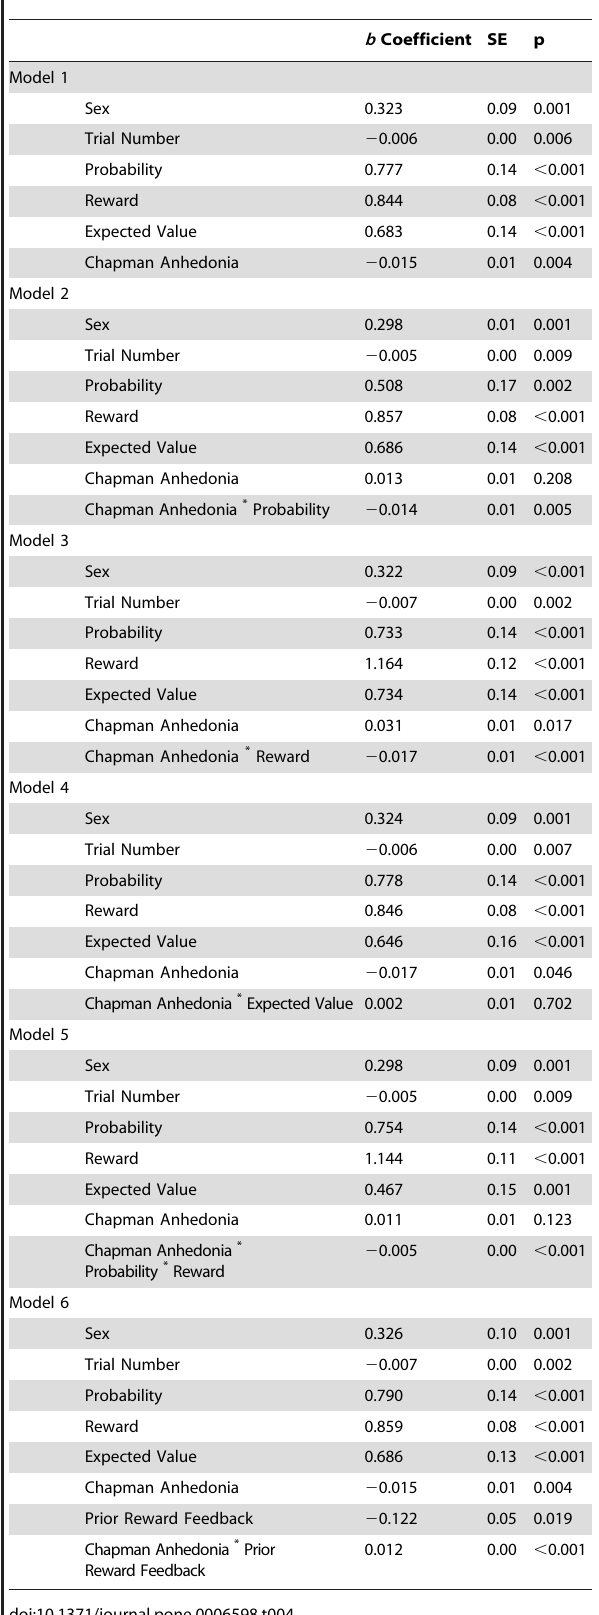
Table 4. Generalized Estimating